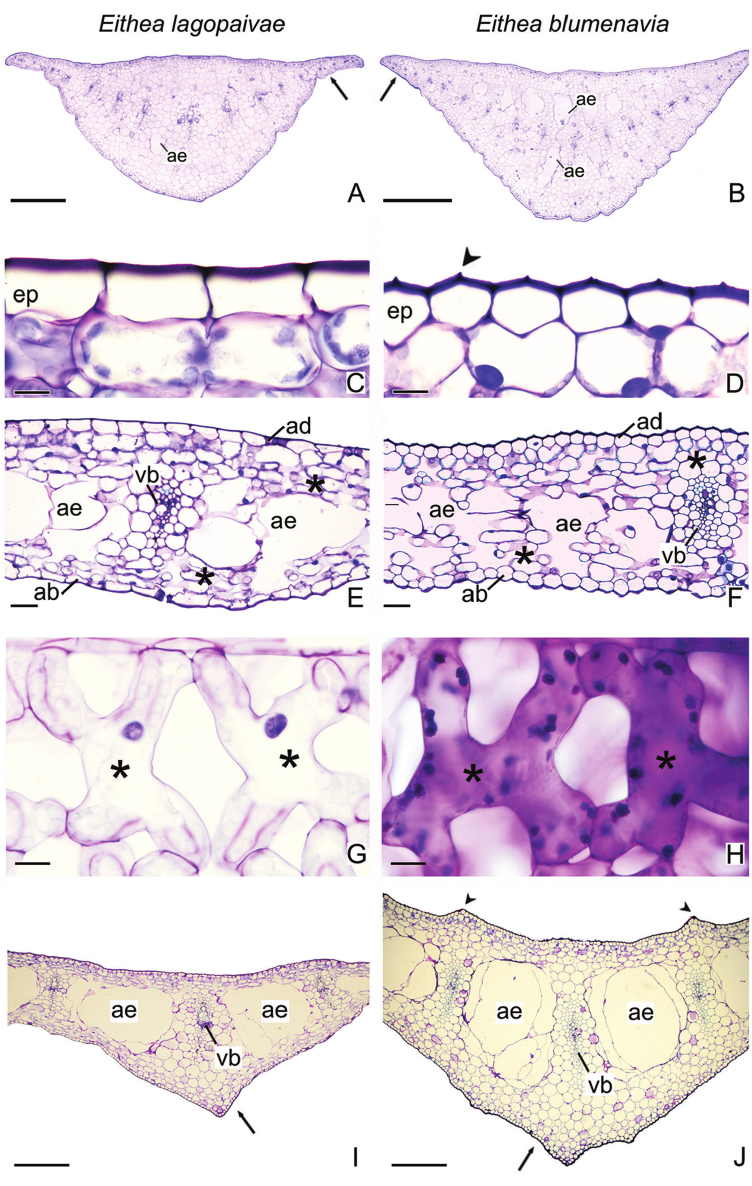
Figure 5. Comparative leaf anatomy of Eithea lagopaivae and E. blumenavia . A Cross section of the pseudopetiole of E. lagopaivae and B E. blumenavia C Cross section detail of the adaxial epidermis of E. lagopaivae and D E. blumenavia E Cross section of the leaf blade of E. lagopaivae and F E. blumenavia G Longitudinal paradermic section detail of the leaf blade, showing the arm-cells of the chlorenchyma in E. lagopaivae and H E. blumenavia (slide of stained fresh material) I Cross section of the leaf blade in the midrib region of E. lagopaivae and J E. blumenavia . * = arm-cell; ab = abaxial epidermis; ad = adaxial epidermis; ae = aerenchyma; ep = epidermis; vb = vascular bundle. Scales bars: 500 µm ( A, B ); 10 µm ( C, D ), 50 µm ( E, F ), 20 µm ( G, H ); 200 µm ( I, J